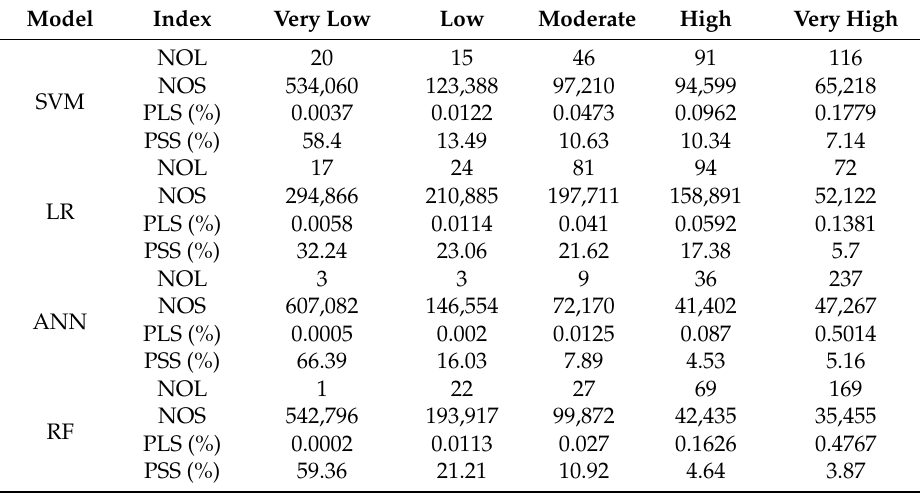
Figure 11. Landslide susceptibility maps: ( a ) SVM model; ( b ) logistic regression (LR) model; ( c ) artificial neural network (ANN) model; ( d ) random forest (RF) model. Table 3. The class-specific accuracies of different models (NOL: number of landslides; NOS: number of SUs; PLS: percentage of landslides to SUs (class-specific accuracy); PSS: percentage of SUs to all SUs in the study